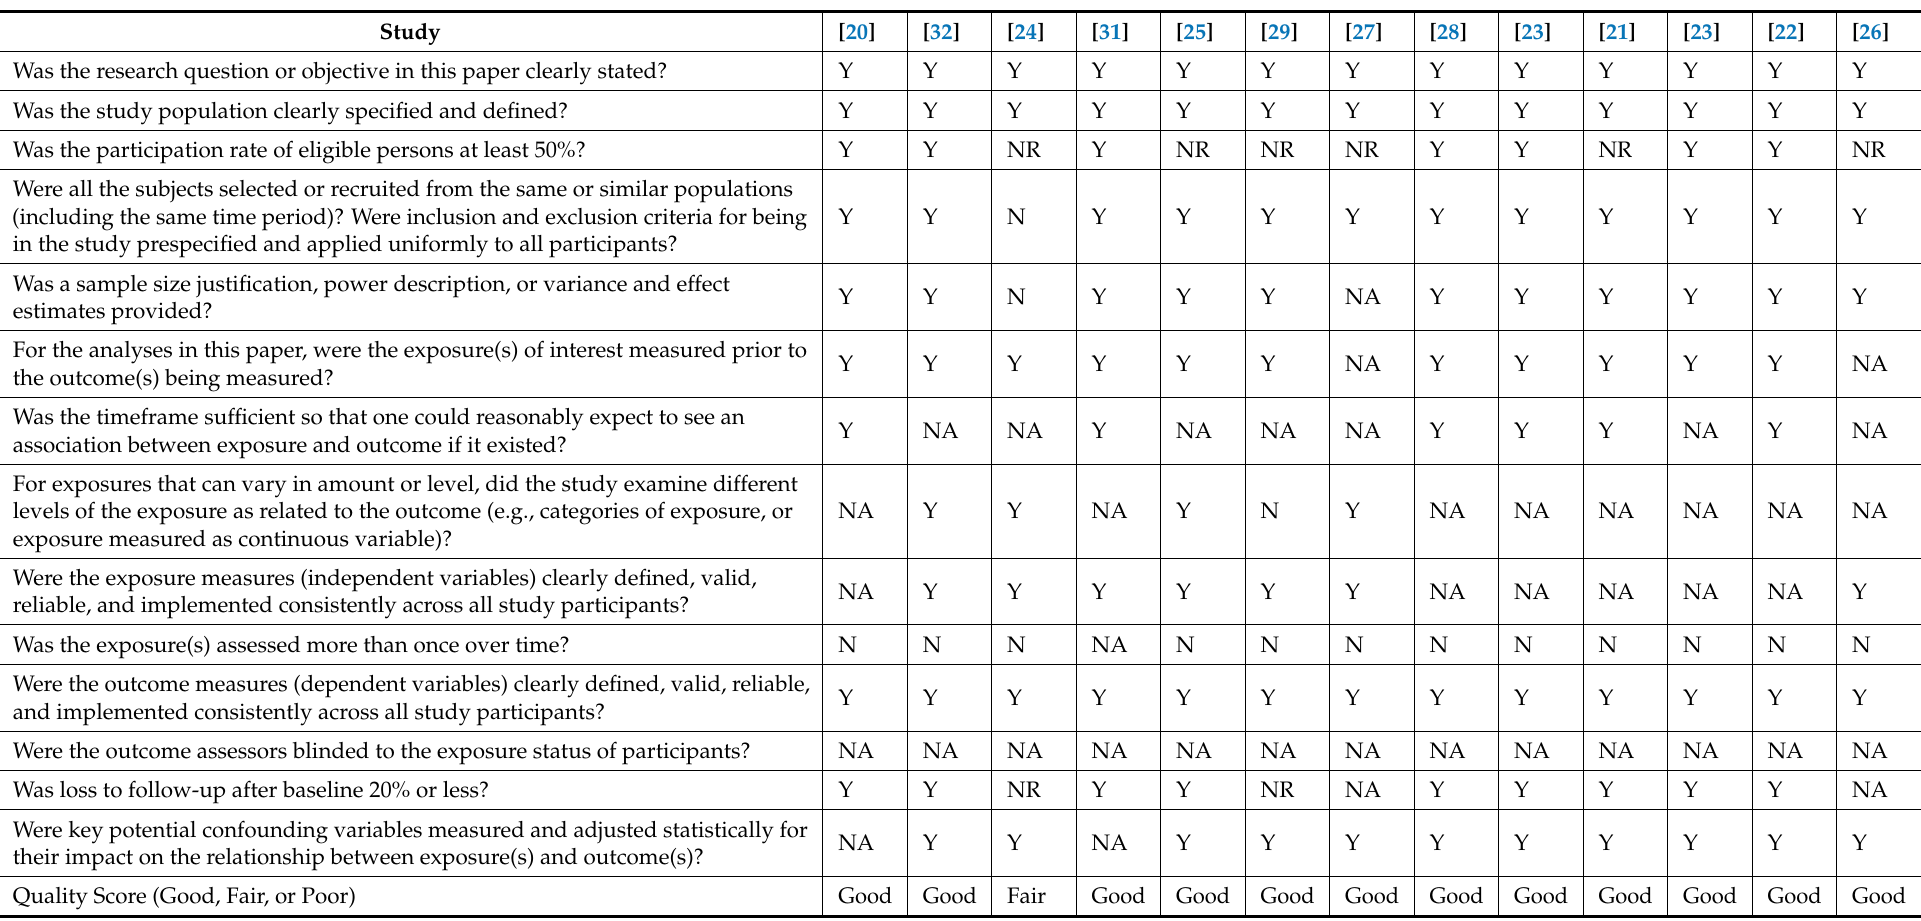
Table 2. National Institutes of Health Risk of Bias